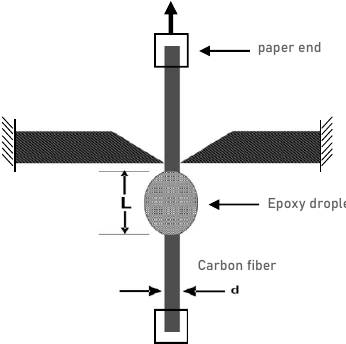
Figure 2. Micro-droplet pull-out test setup.